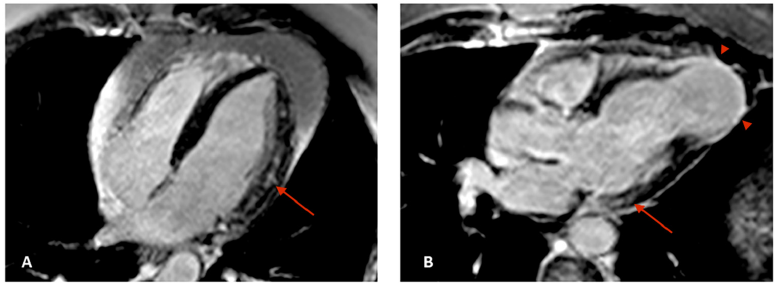
Figure 3. CMR images in four chamber ( A ) and three chamber ( B ) views showing meso-epicardial (arrows) and apical transmural (arrowheads) late gadolinium enhancement (LGE). CMR: cardiac magnetic resonance; LGE: late gadolinium enhancement.